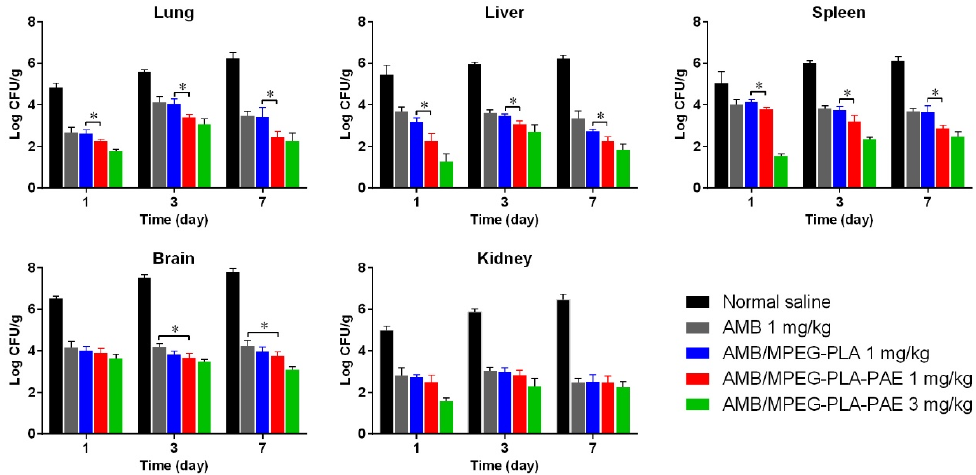
Figure 6. Total burden (lung, liver, spleen, brain, and brain) of mice infected with C. neoformans and treated with either normal saline or the various AMB formulations at 1 or 3 mg/kg (data represented as the mean ± SD; n = 6 for the different treatment groups). Significant differences in fungal tissue burden (lung, liver, and spleen) between the AMB/MPEG ‐ PLA and AMB/MPEG ‐ PLA ‐ PAE group are indicated with * p < 0.05. In addition, fungal burden in brain tissue was significantly ( p < 0.05) different between the AMB and AMB/MPEG ‐ PLA ‐ PAE group.